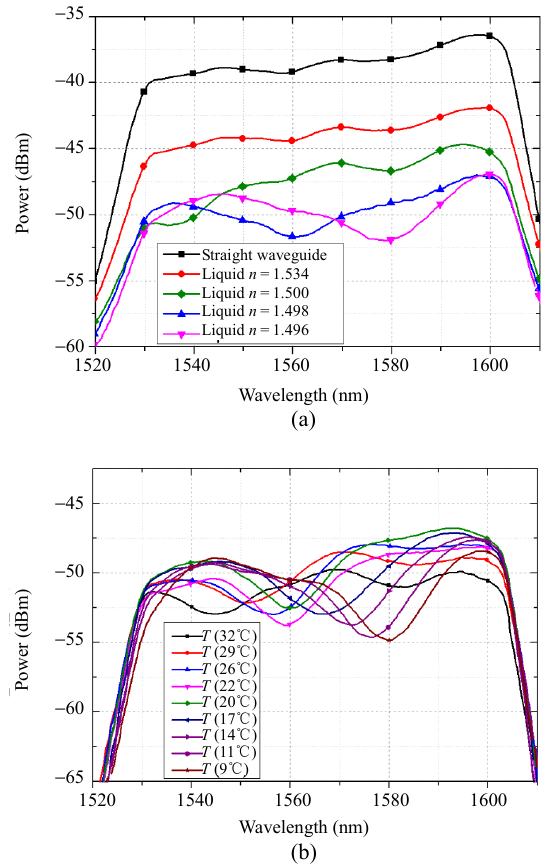
Fig. 3 Transmission spectra of the fabricated waveguide sensors: (a) measured by using different refractive indexes of liquid and (b) measured in different operation temperatures.